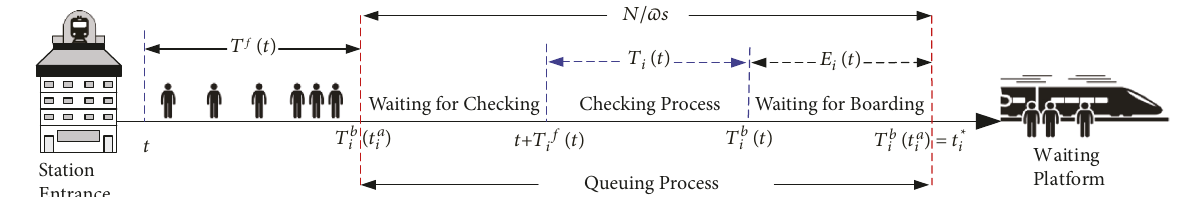
Figure 1: The temporal and spatial boarding process in a metro